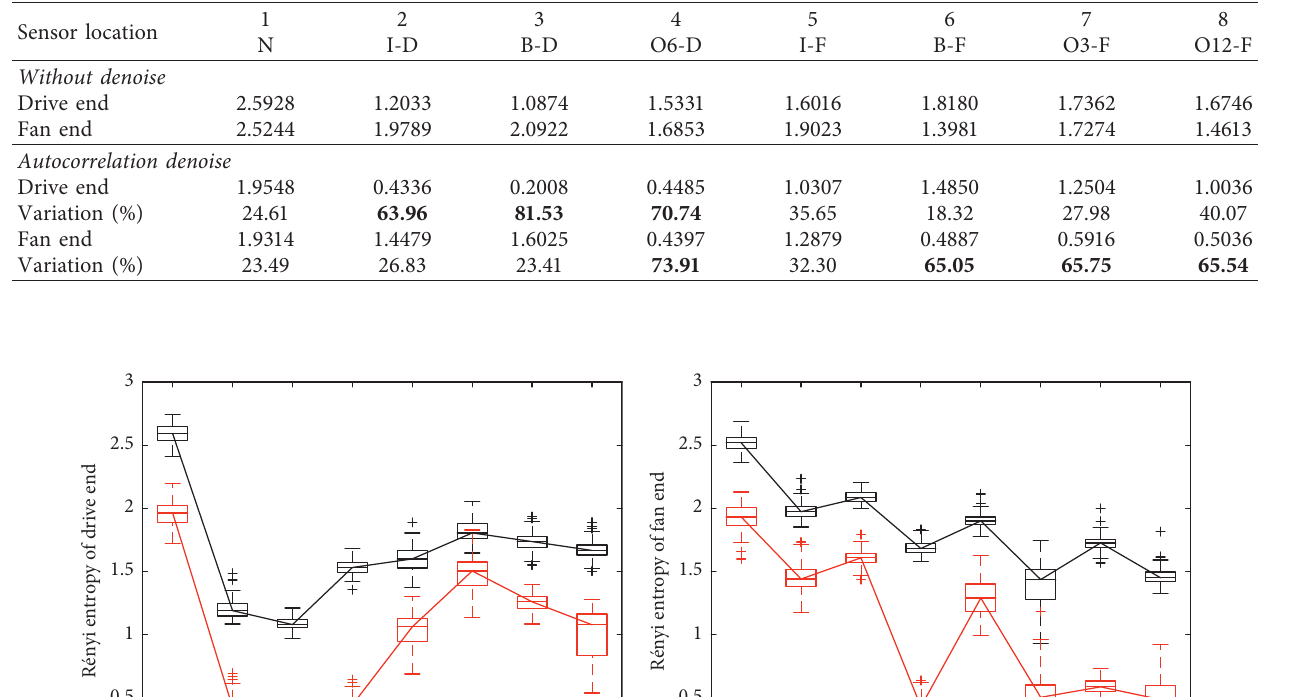
Figure 6: Time domain, autocorrelation function, and corresponding frequency-domain distribution of Res in Figure 5(d). Table 2: Mean values of the R´enyi entropy.